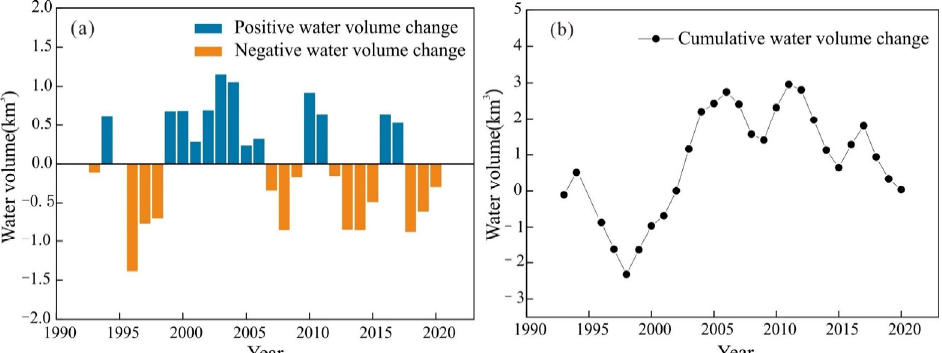
Figure 8. ( a ) Annual variations in water volume and ( b ) cumulative change in the water volume of Lake Issyk-Kul from 1990 to 2020.